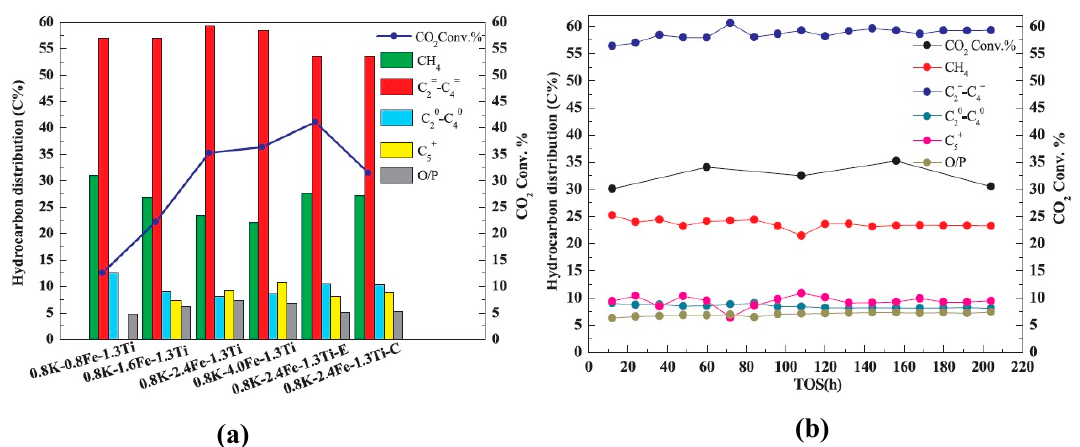
Figure 23. ( a ) Catalytic performance over different catalysts. ( b ) The catalytic stability of 0.8K-2.4Fe-1.3Ti at TOS (testing conditions: H 2 /CO 2 molar ratio = 3/1, T = 593 K, P = 2.0 MPa and GHSV = 10,000 mL gcat − 1 h − 1 ). Adapted with permission from ref. [123]. Copyright 2019 Elsevier.